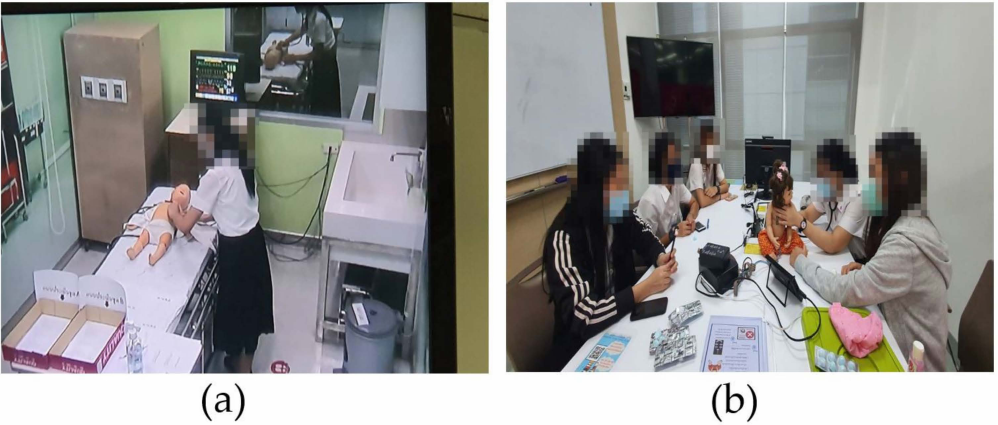
Figure 11. The atmospheres of additional training of ( a ) the control group with the SimBaby and ( b ) the experimental group with the